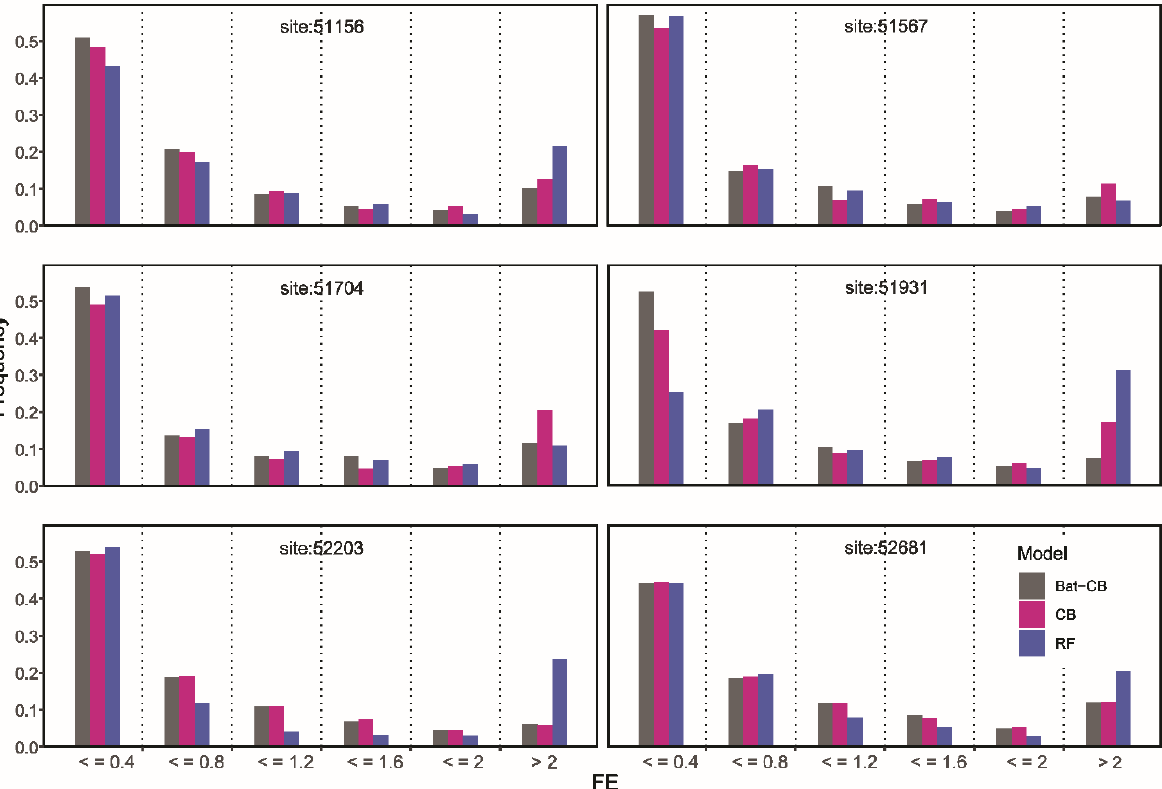
Figure 5. Histograms illustrating the frequency distribution within each of the absolute forecasting error (FE) generated by the three models.